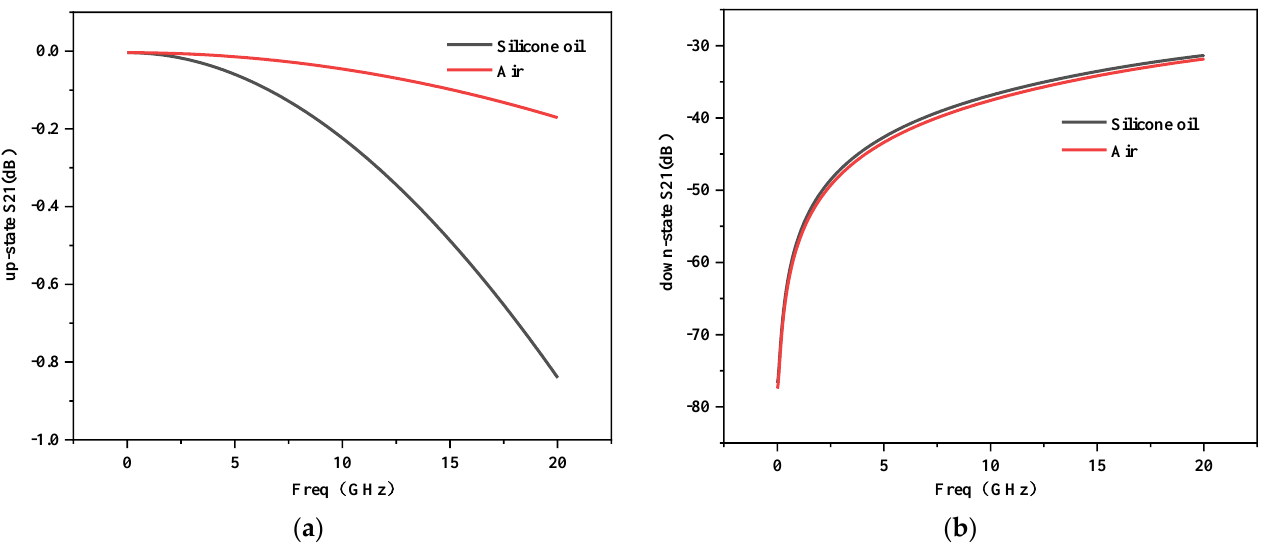
Figure 9. ( a ) Insertion loss when the switch is in the open state; ( b ) isolation when the switch is in the down state. down